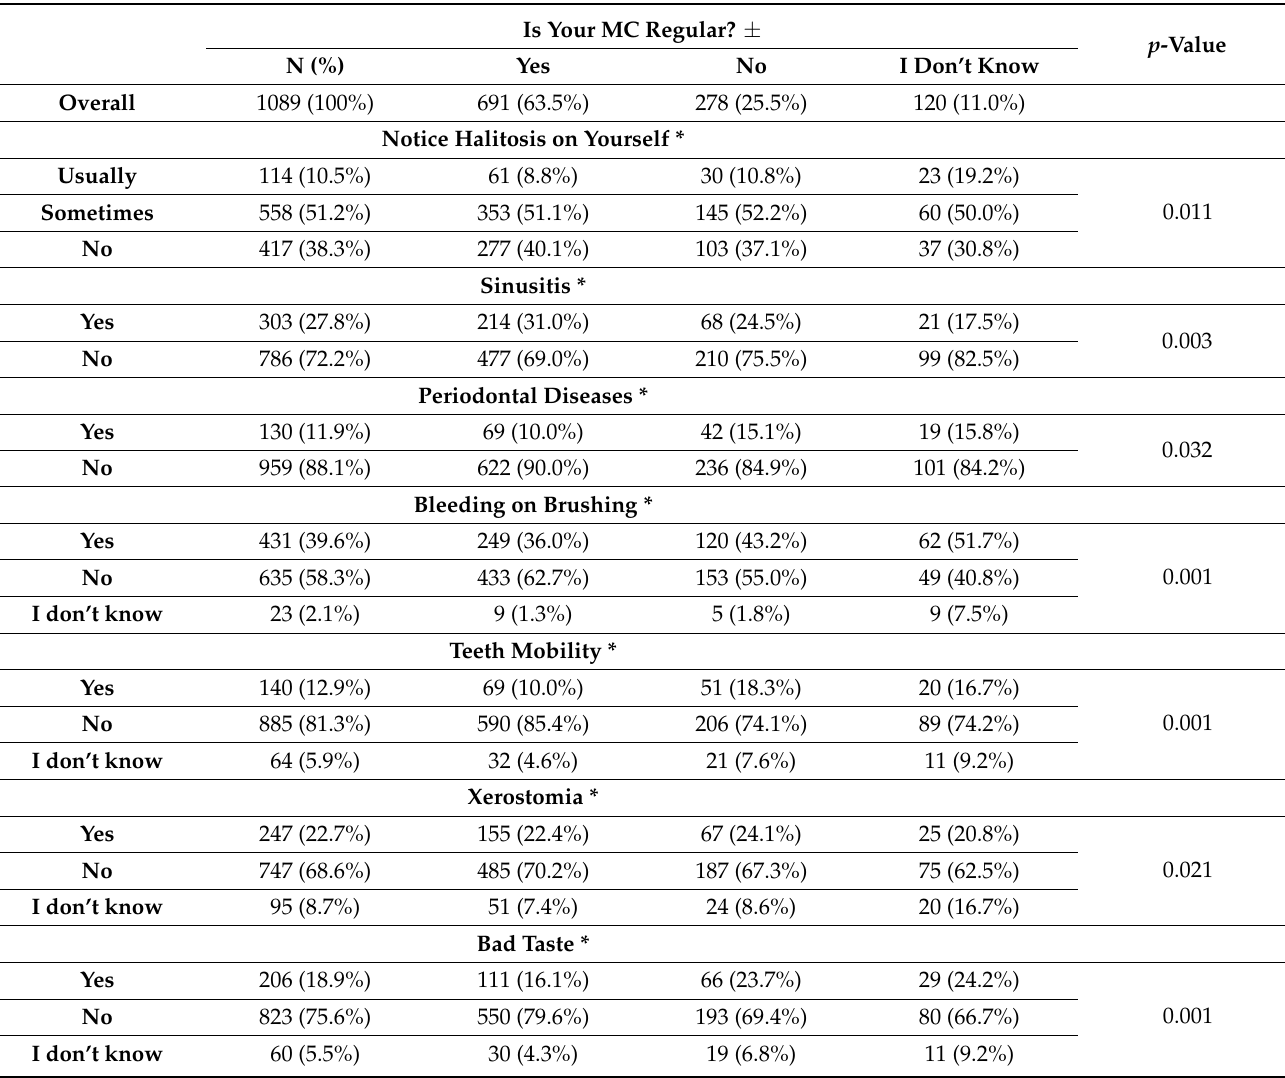
Table 4. Association of several questionnaire domains: (1) halitosis self-perception, (2) halitosis social impact, and (3) menstrual cycle halitosis perception with categories of reported regularity of menstrual cycle, namely, regular, irregular, and do not